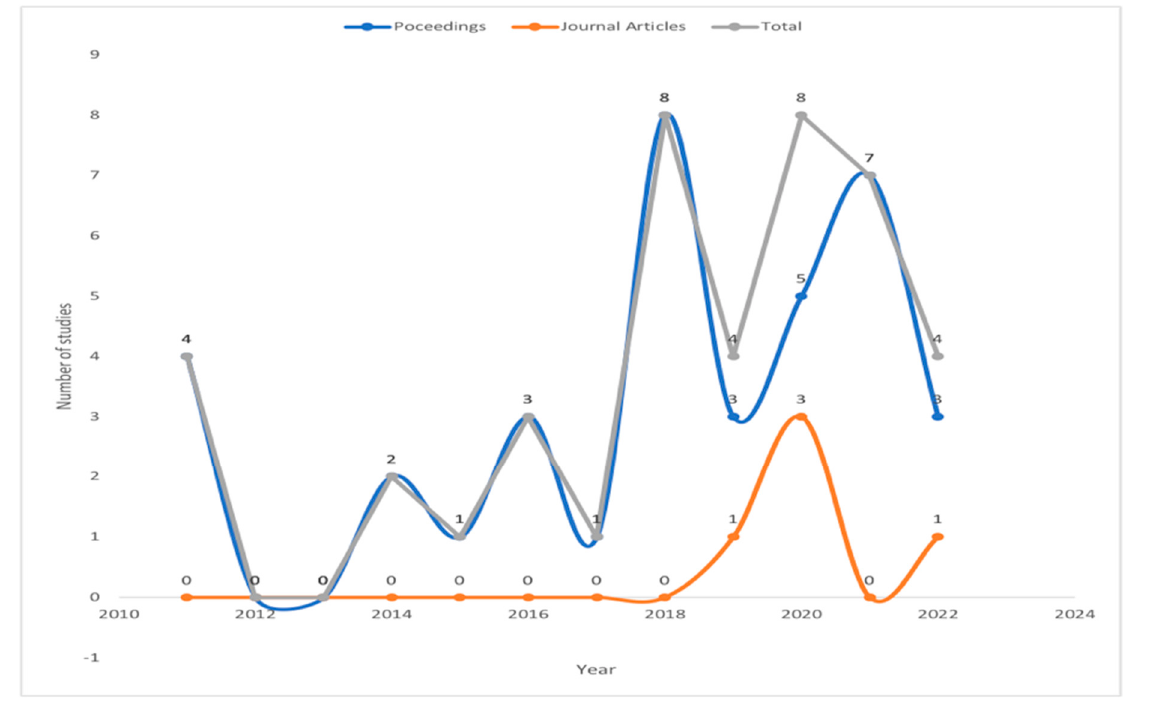
Figure 4. Distribution of selected papers per year. Table 5. VR technology and/or functionality (selected studies).